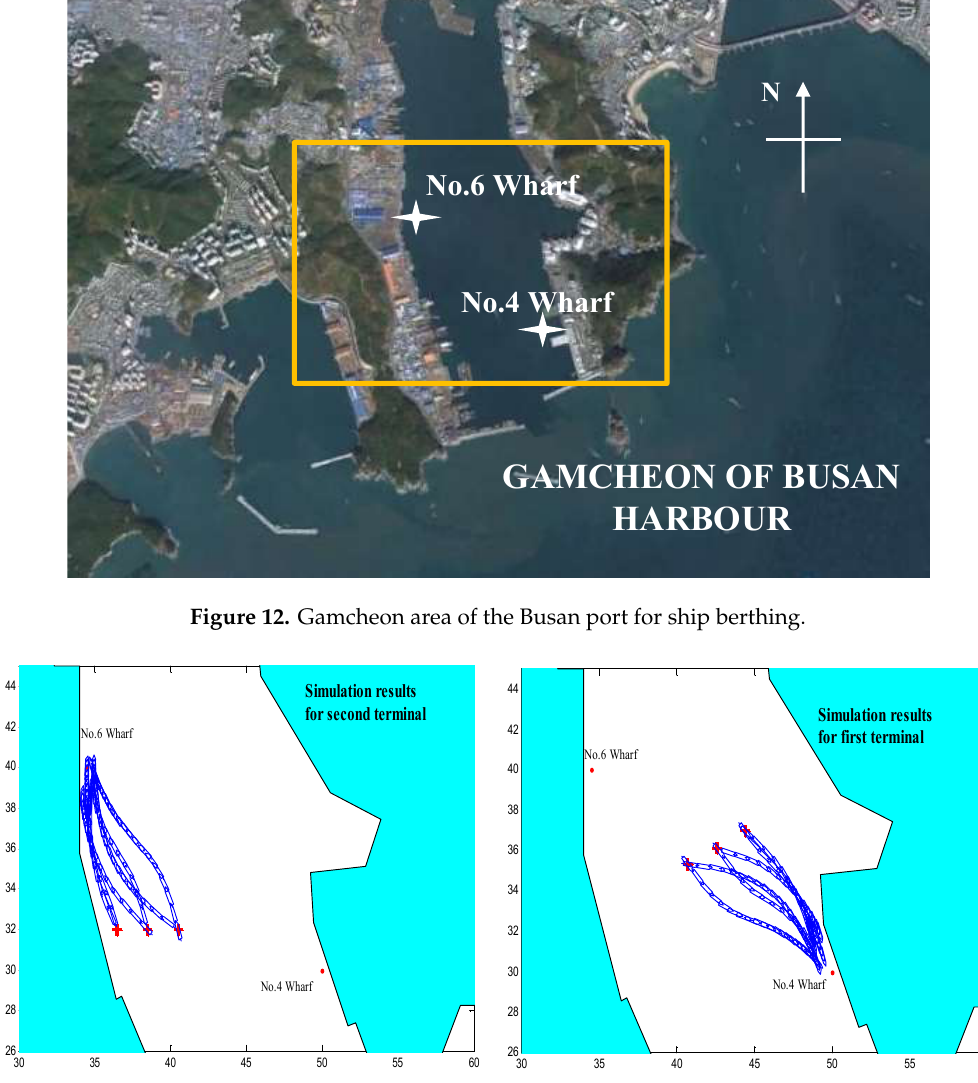
Figure 13. Automatic ship berthing for two terminals of the Busan port.4.3. Verification of Integrated Neural Controller for Berth Approaching on Each Side